Question: Give a one-sentence summary of this figure.
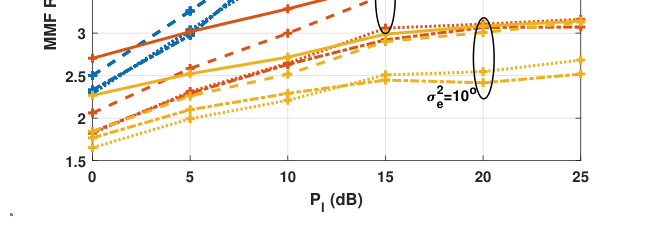
Answer: MMF rate versus LEO SNR Pl with varied satellite phase uncertain- ties. M = 2, Ntg = 4, Ntl = 3, N = 6, K = 4, Pg = 20 dB.